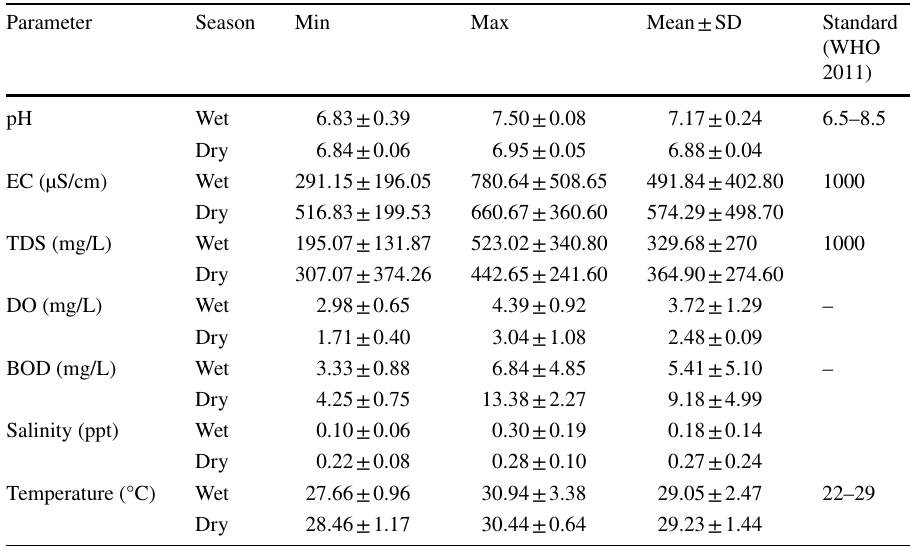
Table 1 Physicochemical parameters of water samples during the wet and dry seasons